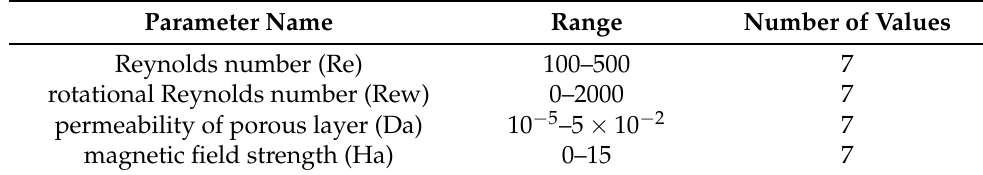
Table 1. Input–output data